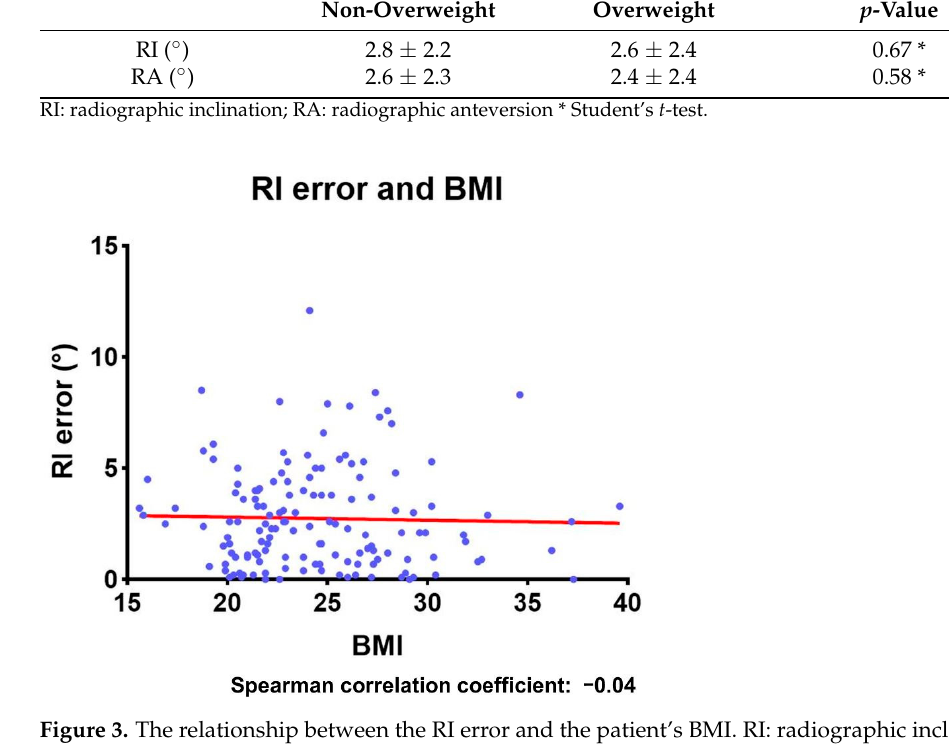
Table 2. Navigation errors of the acetabular cup angle.